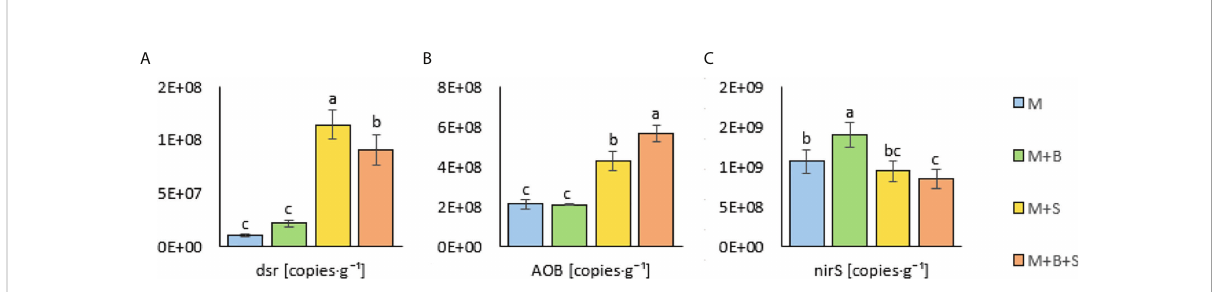
FIGURE 4 Microbial properties of the maturated manures enriched with additives (biochar and S). (A) sulphur-reducing, (B) ammonia-oxidizing, and (C) denitrifying microorganisms in the maturated manures enriched with additives. Different letters indicate differences at level of signi fi cance p ≤